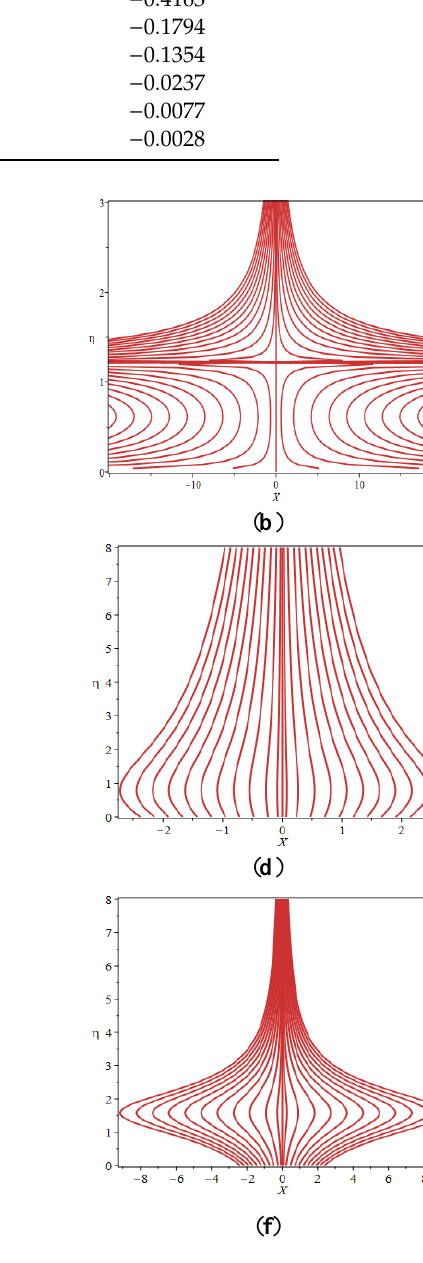
Figure 6. Streamlines when Rd = 1.2, m 0 = 1.5,Pr = 4.36, De = 1.5, φ = 0.02, M = 0.5; ( a ) s = 0, ε = 1.4; ( b ) s = 0, ε = − 1.4; ( c ) s = 7, ε = 1.4; ( d ) s = 7, ε = − 1.4; ( e ) s = 7, ε = 4; ( f ) s = 7, ε = −